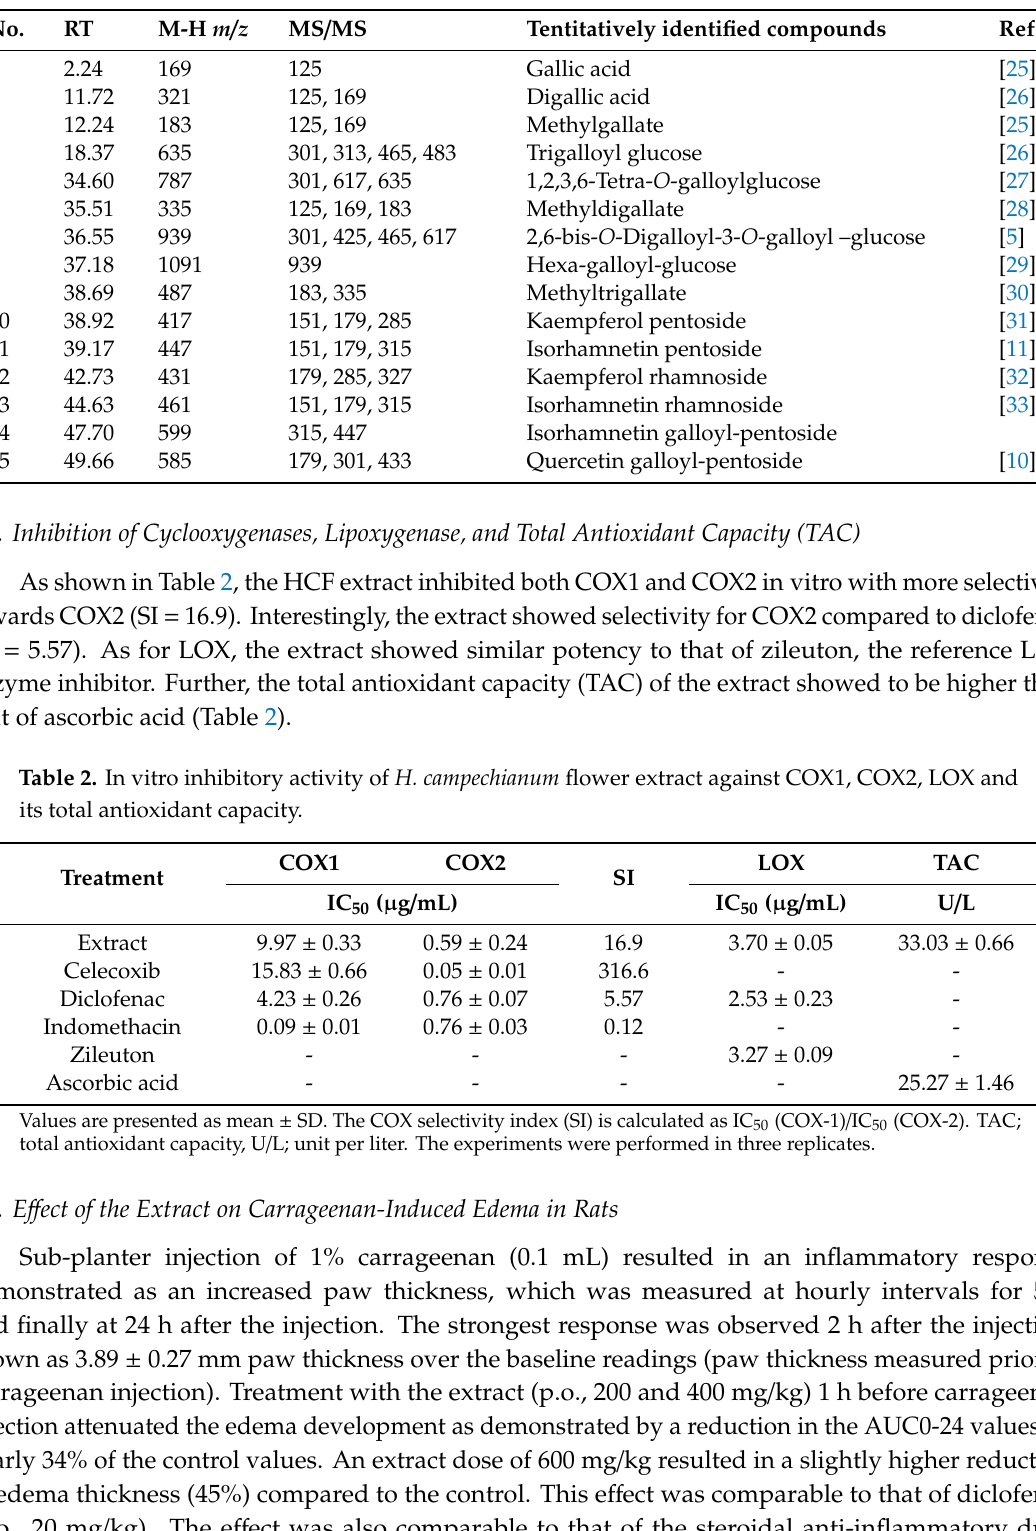
Table 1. List of identified secondary metabolites from H. campechianum flowers using LC–MS / MS analysis.